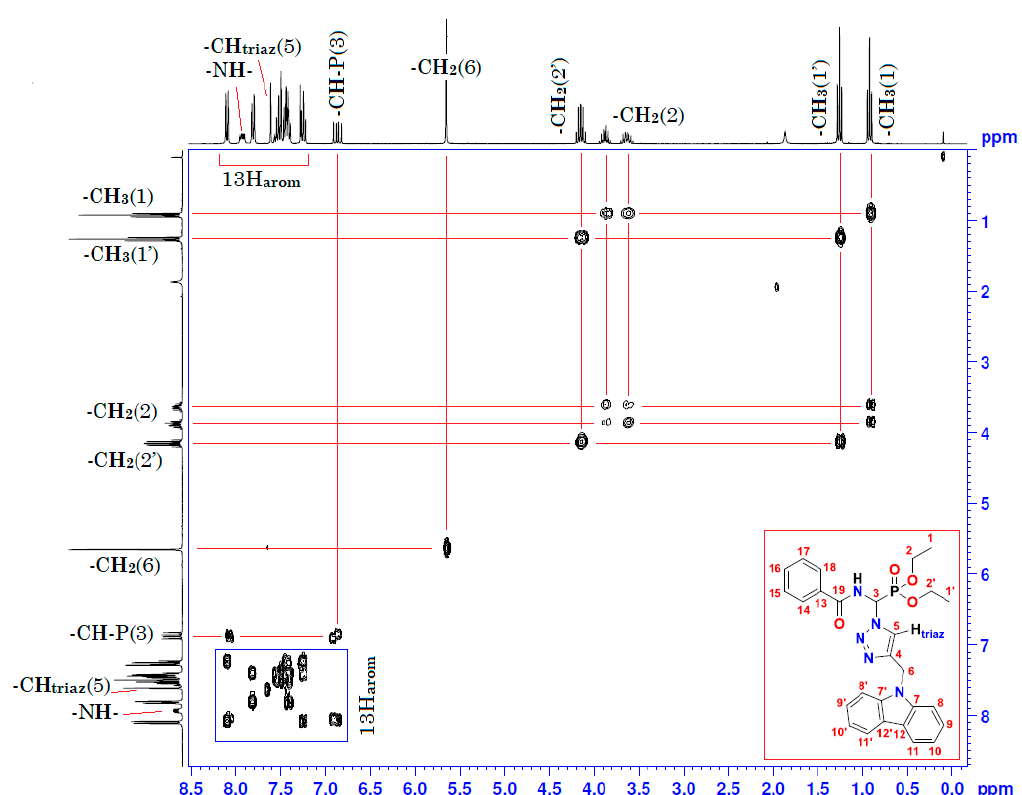
Figure 4. Homonuclear 1 H- 1 H 2D spectrum of compound ( 3 ).